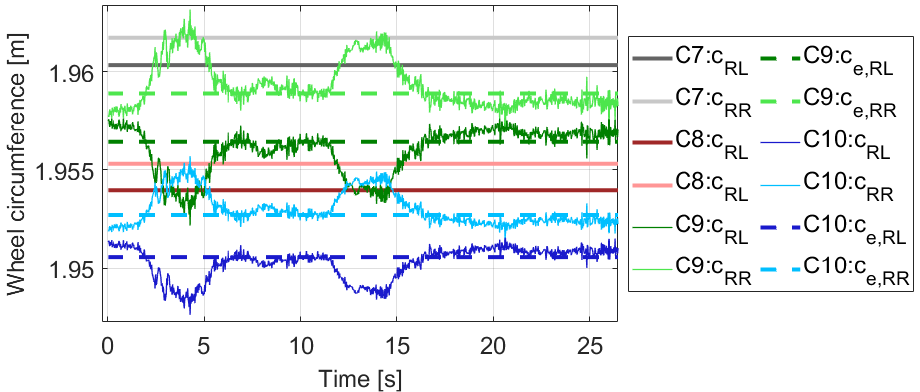
Figure 5. Wheel circumferences of the motivation